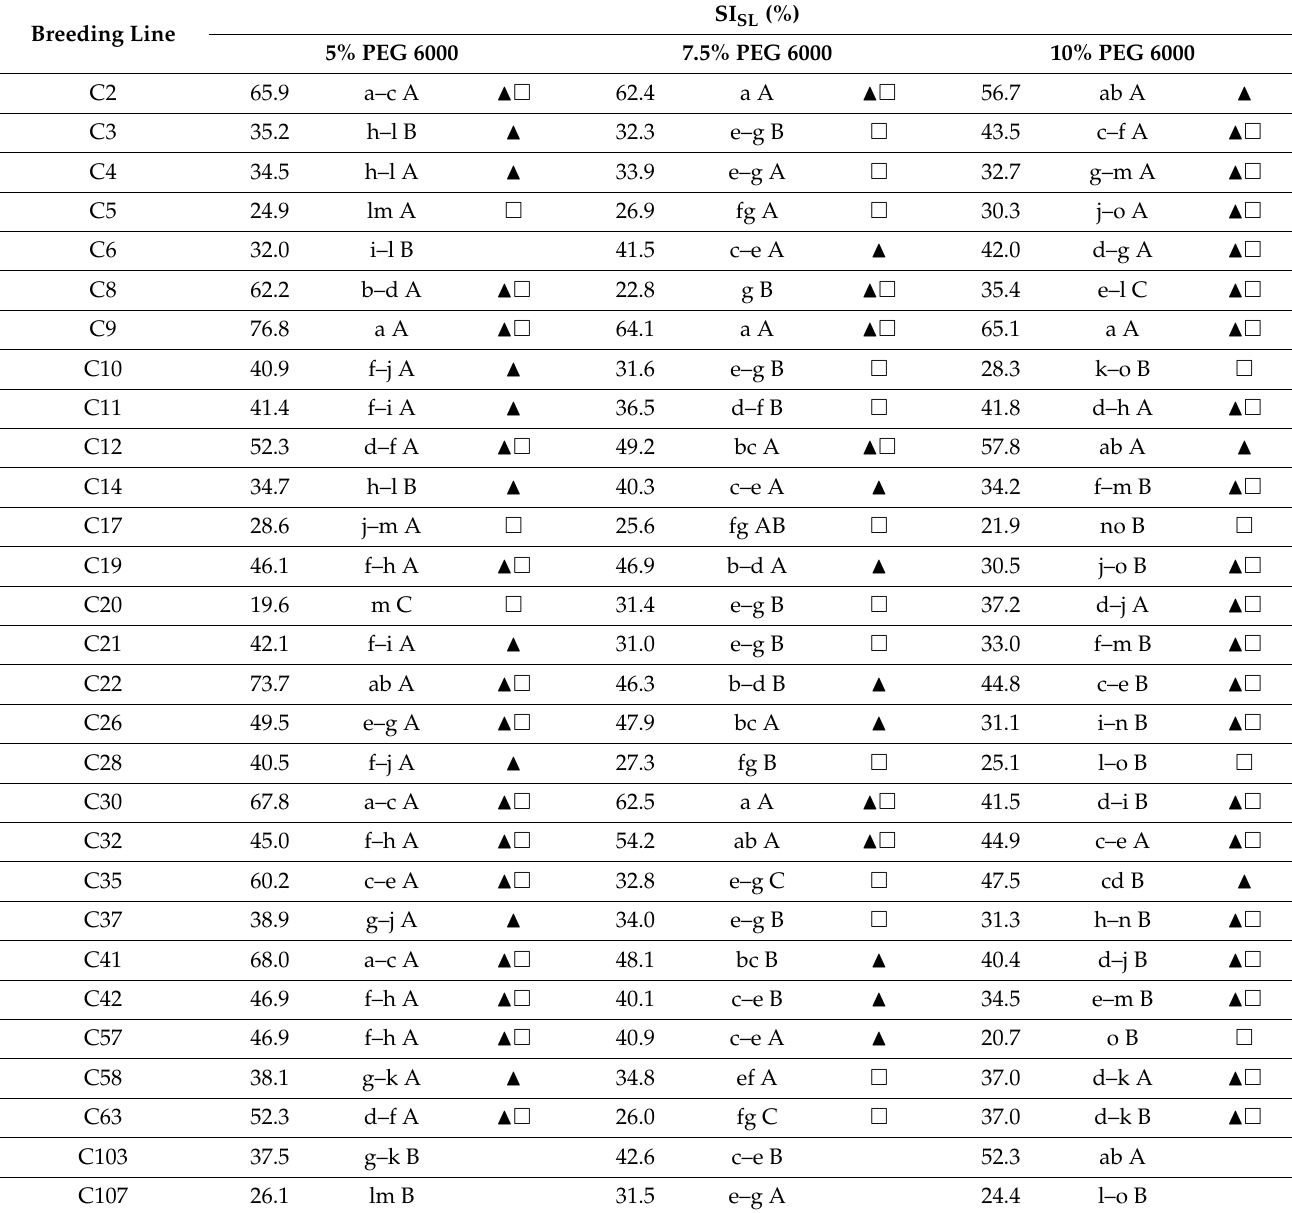
Table 3. Shoot length SI values (SI SL ) of potato genotypes under osmotic stress induced by PEG 6000 added to the medium at levels of 5.0%, 7.5% and